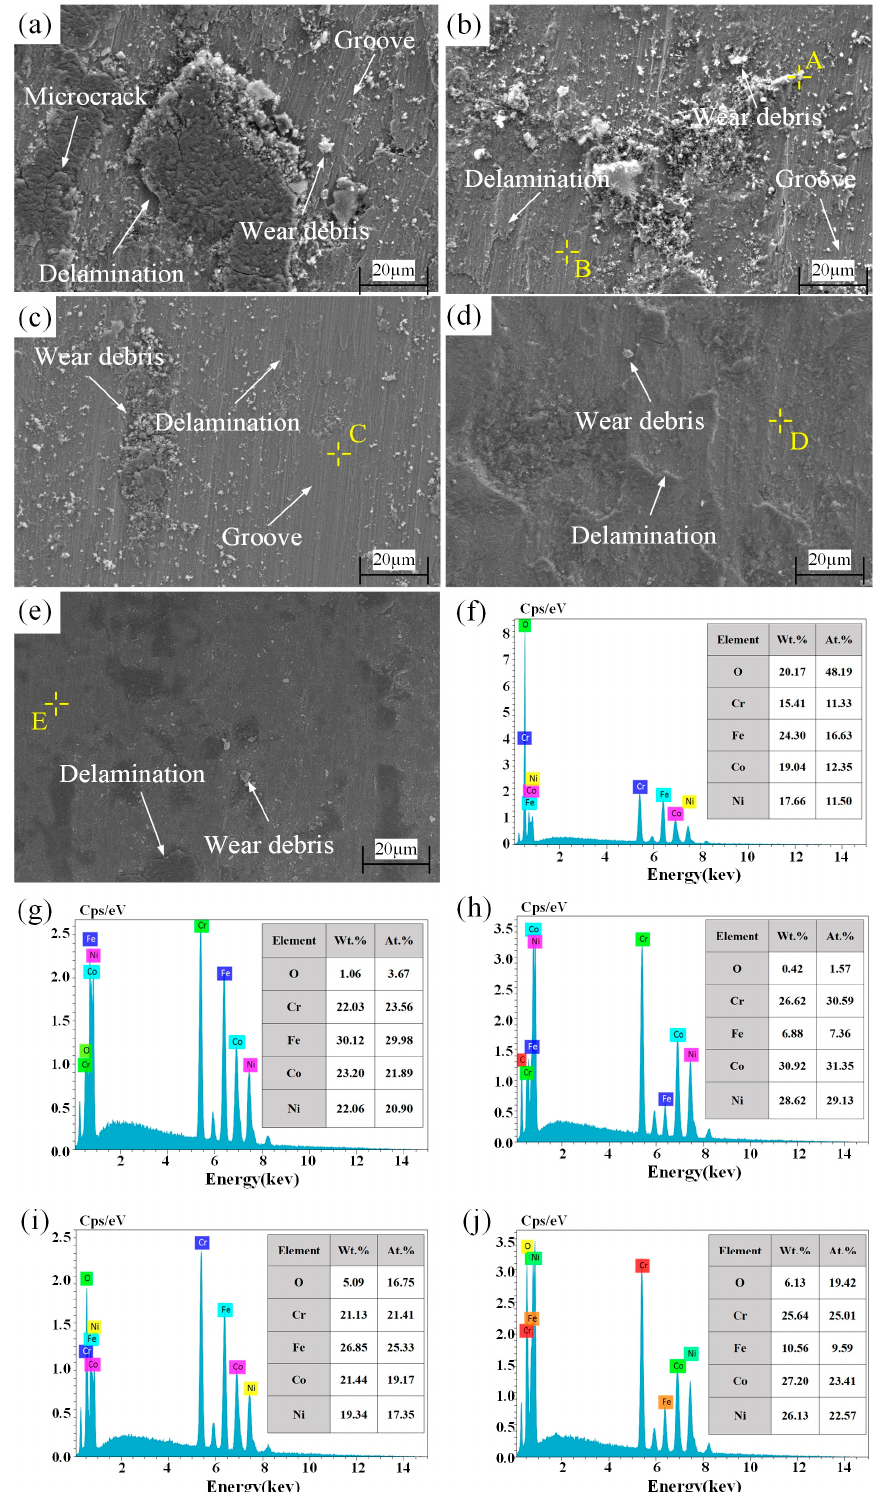
Figure 12. SEM images of wear areas and EDS analysis. ( a ) HT(GCr15), ( b ) LC(FeCoNiCr), ( c ) LC(CoCrNi), ( d ) UB(FeCoNiCr), ( e ) UB(CoCrNi), ( f ) element analysis of wear debris A of LC(FeCoNiCr), ( g ) element analysis of wear scar B of LC(FeCoNiCr), ( h ) element analysis of wear scar C of LC(CoCrNi), ( i ) element analysis of wear scar D of UB(FeCoNiCr), and ( j ) element analysis of wear scar E of UB(CoCrNi).